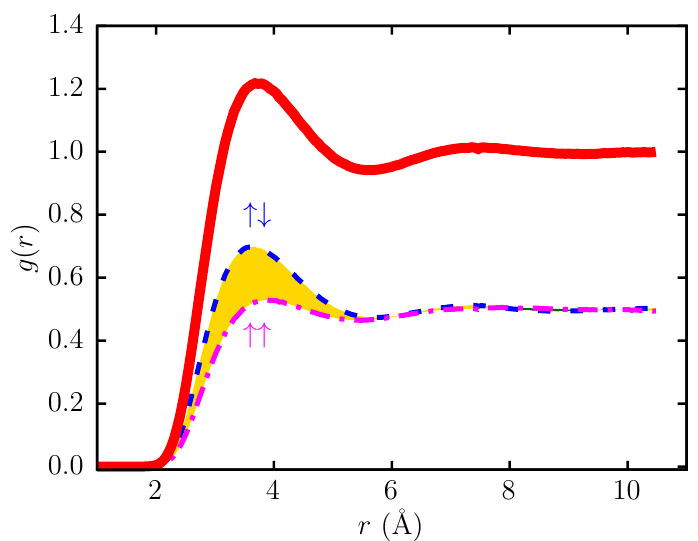
Figure 10: Total pair correlation functions (solid red line) and its components, the antiparallel (dashed blue line) and the parallel spins functions (dashed-dotted ma- genta line) versus the radial distance. The yellow shaded area shows the region where the pair correlation of antiparallel spin is larger than that of parallel spins. Between r = 8 Å and r = 10 Å there is a region where the antiparallel pair function is smaller than the one for parallel spins. This region is not easily seen in the figure scale, even though it is depicted in